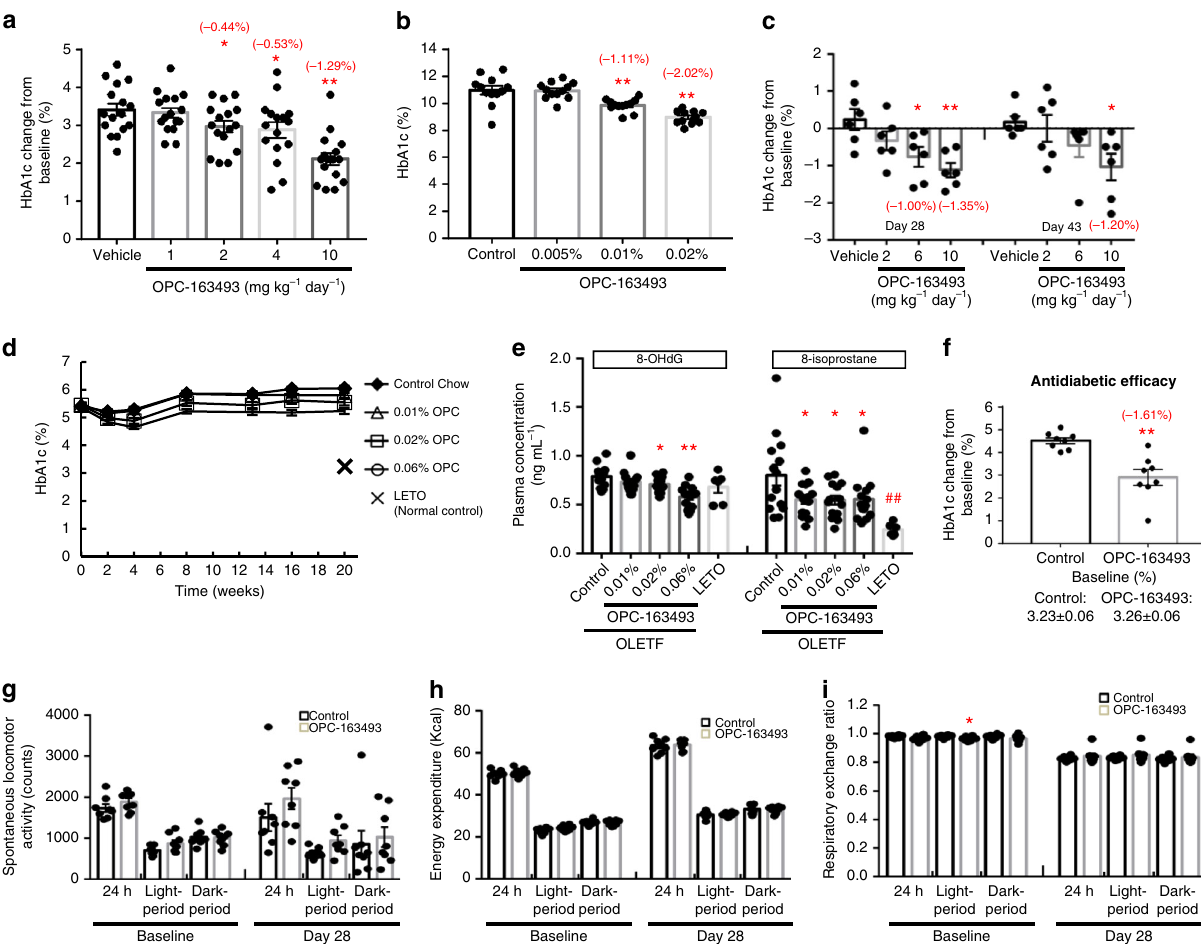
Fig. 2 Antidiabetic effects of OPC-163493 in a wide variety of animal models. a Effect of repetitive oral dosing with OPC-163493 (BID) on HbA1c changes from baseline in male ZDF Rats. OPC treatments were performed on rats aged between 11 and 17 weeks. Data represent mean ± SE ( n = 16). Signi fi cant ef fi cacy was found in the 2, 4, and 10 mg kg − 1 day − 1 OPC-163493-treated groups ( ∗ P < 0.05, ∗∗ P < 0.01, OPC vs. vehicle group using Williams ’ test with two-way ANOVA). b Effect of OPC-163493 dosing with mixed chow on HbA1c values in male Akita mice. OPC treatments were performed on mice aged between 6 and 12 weeks. Data represent mean ± SE ( n = 12). Signi fi cant ef fi cacy was found in the 0.01 and 0.02% OPC-163493-treated groups ( ∗∗ P < 0.01, OPC vs. control chow group using a two-tailed Williams ’ test). c Effect of OPC-163493 repetitive oral dosing (BID) on HbA1c changes from baseline in old male ZDF rats having extreme insulin resistance. OPC treatments were performed on rats aged between 27 and 33 weeks. Data represent mean ± SE ( n = 6). Signi fi cant ef fi cacy was found in the 6 and 10 mg kg − 1 day − 1 OPC-163493-treated groups on day 28, and in the 10 mg kg − 1 day − 1 OPC-163493-treated group on day 43 ( ∗ P < 0.05, ∗∗ P < 0.01, OPC vs. vehicle group using a two-tailed Williams ’ test). d Long-term effect of OPC-163493 dosing with mixed